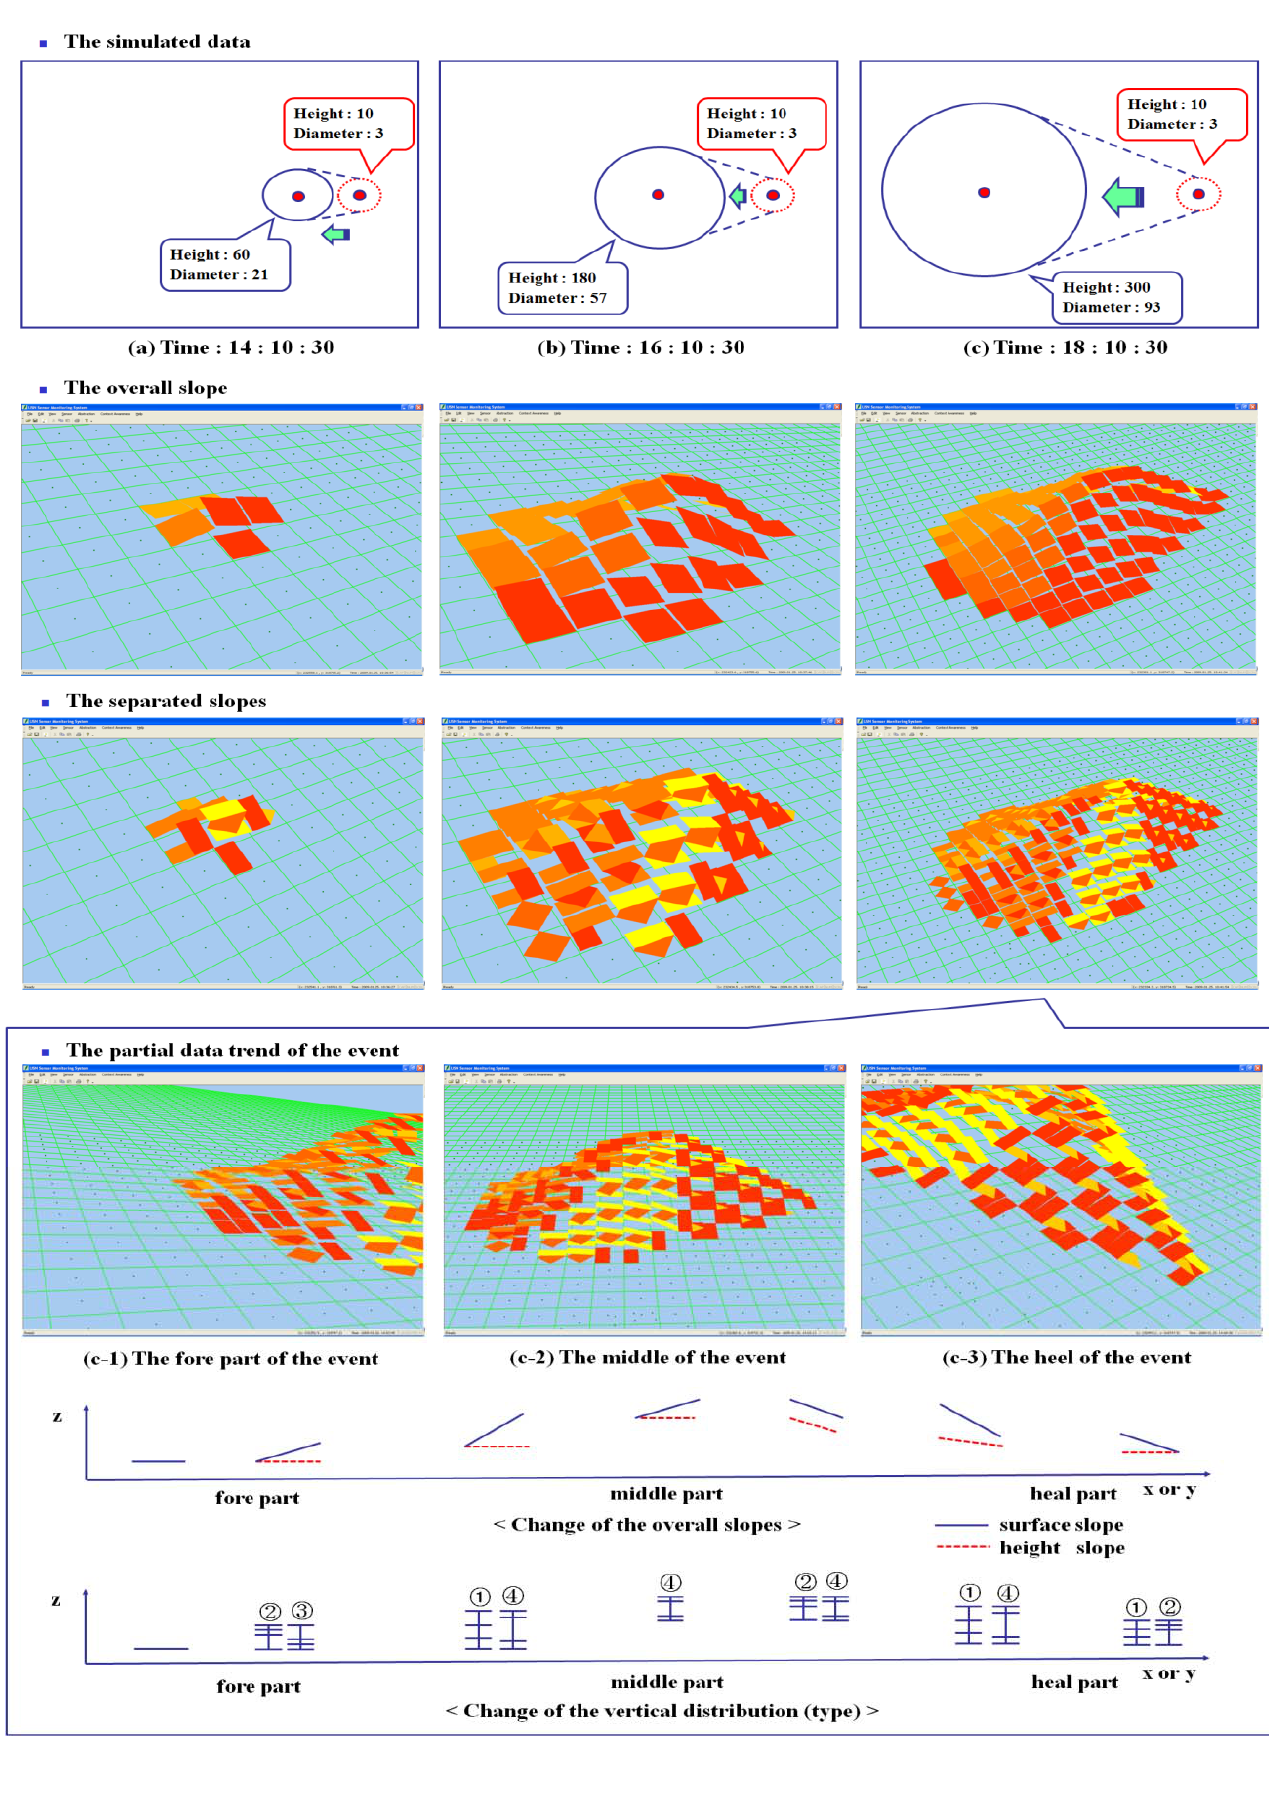
Figure 10. Tracking the simulated phenomenon with